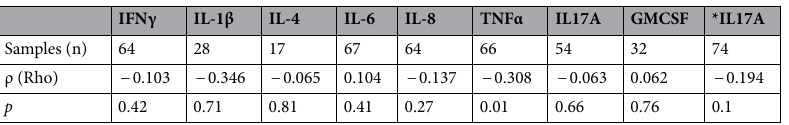
(Table 5: Sample age (years)). Somewhat mitigating this, the majority of samples were collected and stored for a similar duration before use. While degradation is highly likely to have occurred in each sample, we expect that, as all samples were stored under similar conditions, that the degree of cytokine degradation is comparable across all samples. To test this, we correlated sample age with the concentrations of each analyte (see Table 6). We found that seven of nine analytes correlated negatively with sample age suggesting some degradation over the period from the most recent to the earliest sampling. Two analytes, IL-6 and GM-CSF, correlated positively but the cor- relations were “weak” and “negligible” respectively. One analyte, TNFα demonstrated a significant “fair” nega- tive correlation 46 with sample age ρ (Rho) − 0.308 (p = 0.01), which is also reflected by linear regression analysis (F1, 63) = 5.037; p = 0.028. R 2 = 0.074 47 . This finding confirms significant and moderate TNFα degradation in